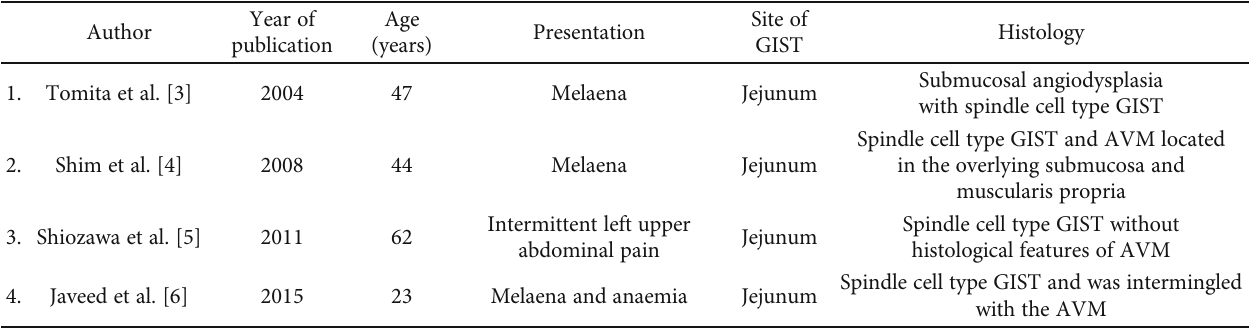
Figure 5: Macroscopic appearance of the tumour cross-section: red arrows show the jejunal lesion arising from the wall; yellow arrows show the jejunal lumen. Table 1: Summary of previous case reports that described a similar